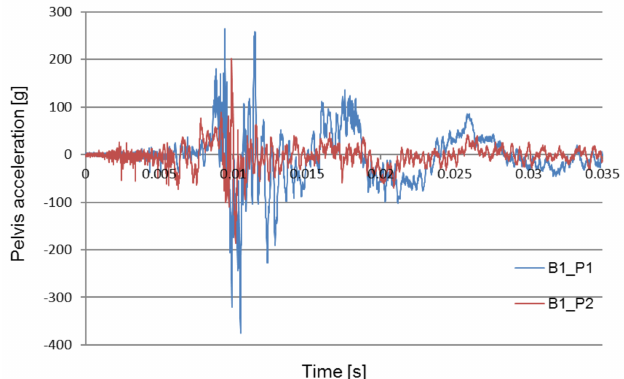
Figure 8. Comparison of two pelvis acceleration signals without the use of the anti-explosive seat.